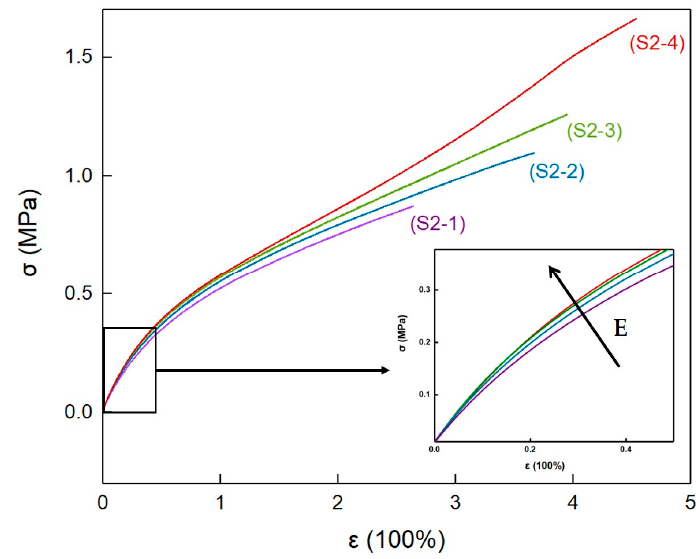
Figure 9. Stress–strain curves of elastomers with different PEG contents.